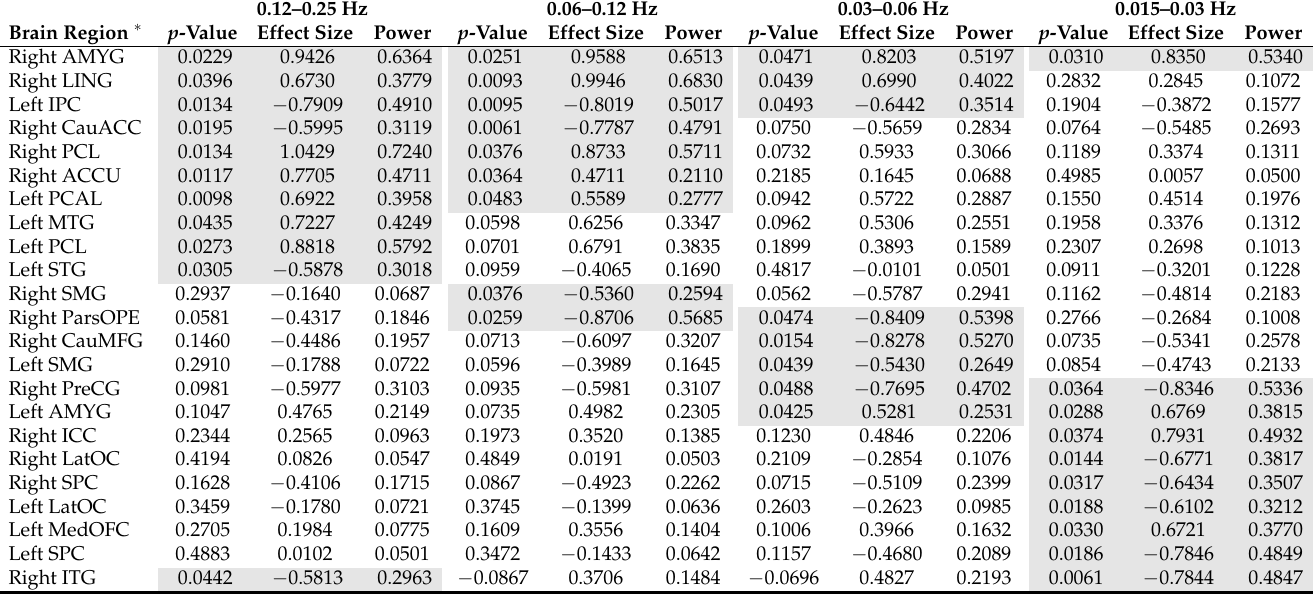
Table 5. Effect size, p -value, and power of brain regions that show changes in degree after treatment in at least one of the frequency bands. (Shadowed values indicate uncorrected p -value < 0.05). Sign and magnitude of the effect size indicate the direction and significance of